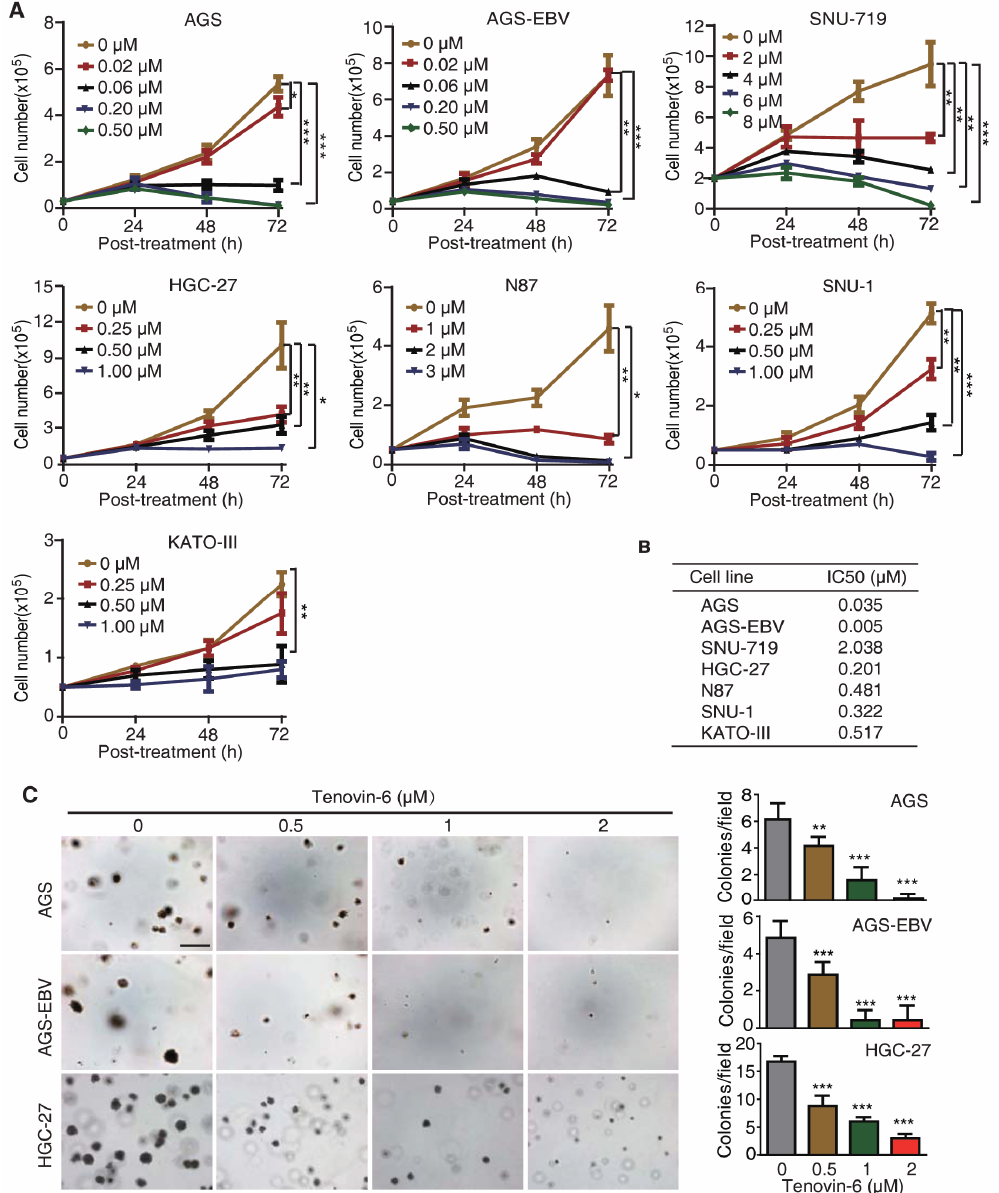
Figure 1. Tenovin-6 inhibits cell proliferation and anchorage-independent growth of gastric cancer (GC) cells. ( A ) Examination of cell proliferation following treatment with Tenovin-6. Cells seeded at 2.5 × 10 4 or 5 × 10 4 cells/well were treated with the indicated concentrations of Tenovin-6 and counted at 24, 48, and 72 h post treatment. * p < 0.05, ** p < 0.01, *** p < 0.001. ( B ) The half maximal inhibitory concentration (IC 50 ) values were calculated using SPSS software based on the relative cell numbers at 72 h post treatment in all GC cell lines. ( C ) Suppression of anchorage-independent growth of AGS, AGS-EBV, and HGC-27 cells by Tenovin-6. Representative pictures captured at 5× magnification are presented in the left panel. Colonies with diameter >50 μm were counted, and colony numbers in each field are presented in the right panel. * p < 0.05, ** p < 0.01, *** p < 0.001. Scale bar: 500 μm.